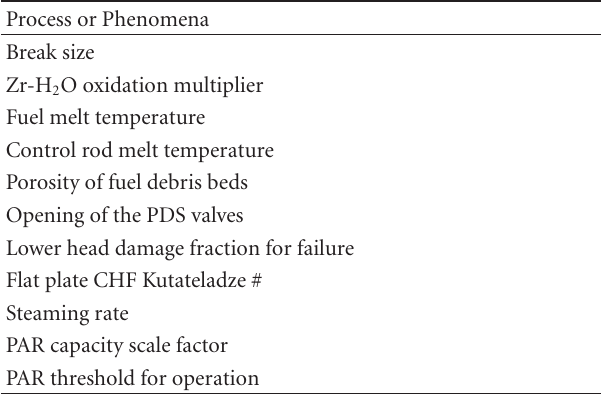
Table 6: Dominant Severe Accident Phenomena. Process or Phenomena Break